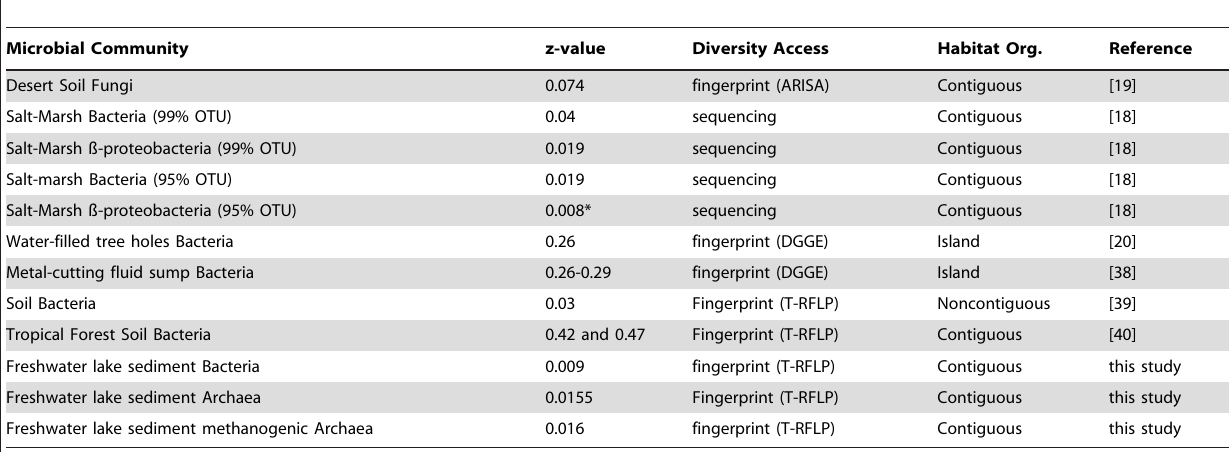
Table 2. Z-values previously described for microorganisms, 99% or 95% represent the taxonomic resolution applied for definition of the OTUs (sequence